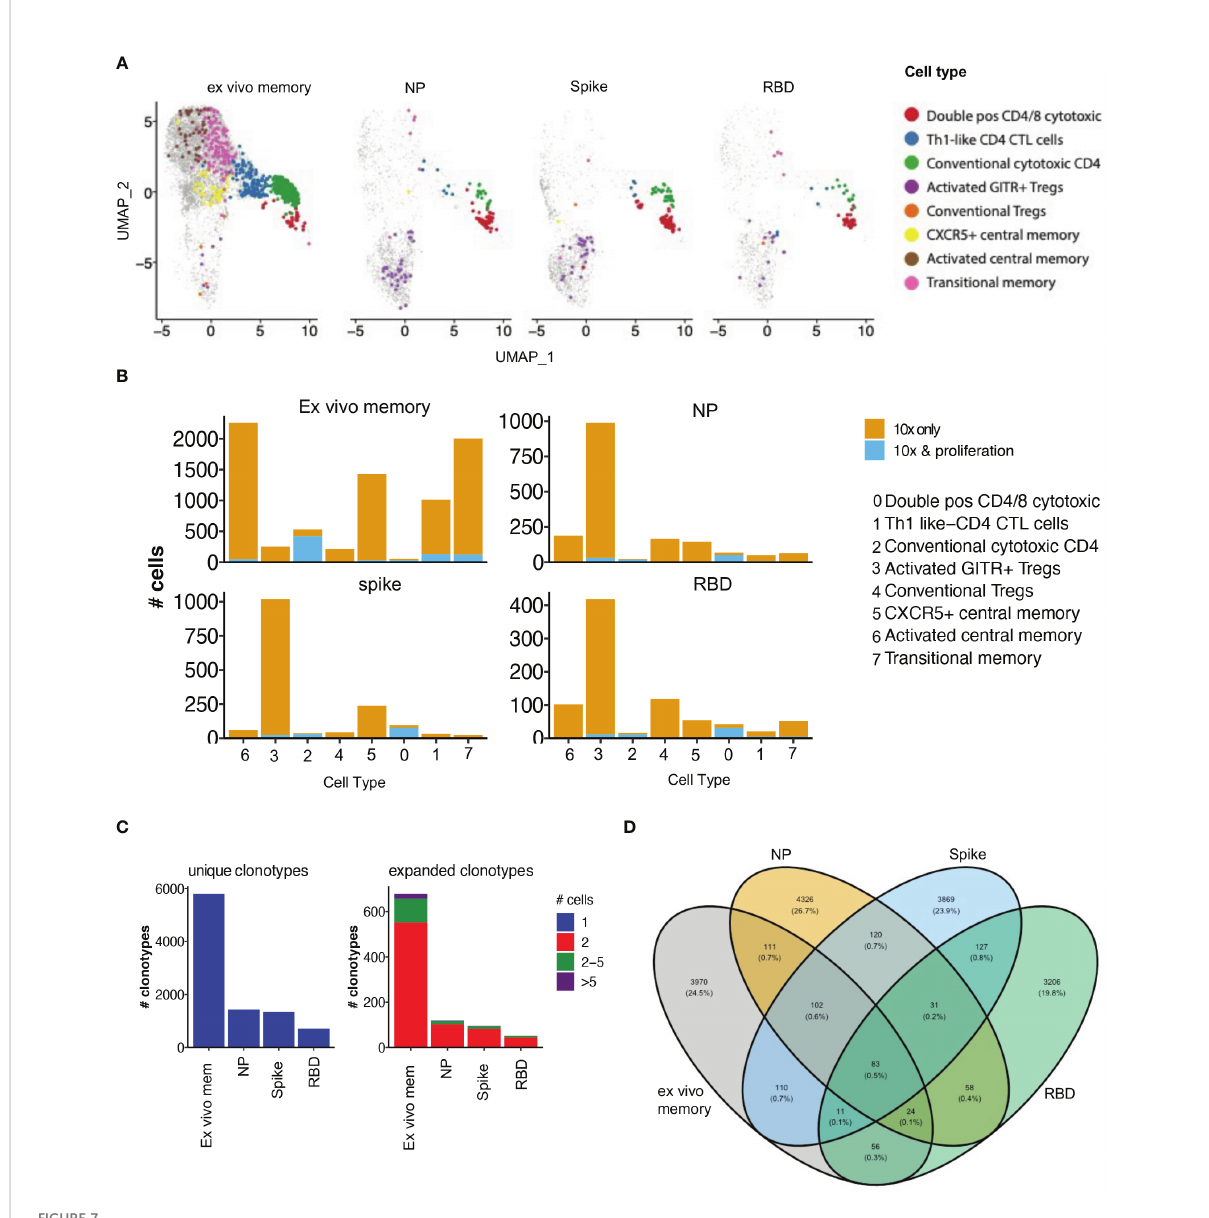
FIGURE 7 Proliferative clonotypes are enriched within Tregs and cytotoxic subsets. Bulk TCR sequencing of CD4s T cells from Ab high subjects that proliferated for 5 days following stimulation with SARS-CoV-2 peptide pools were matched with 10x single-cell TCRs to examine enriched clonotypes. (A) UMAP clonotypes that were enriched following proliferation and matched to 10x TCRs and split into 4 conditions: ex vivo memory, nucleoprotein (NP), Spike and RBD. (B) Proliferative CD4 clones were highly enriched with activated GITR+ Tregs and cytotoxic clusters. (C) Abundance of unique single clonotypes with few expanded clonotypes within stimulated conditions. (D) Minimal shared TCR clonotypes within stimulated conditions compared to ex vivo memory. Fishers exact test with Bonferroni ’ s corrected p values shown for log odd